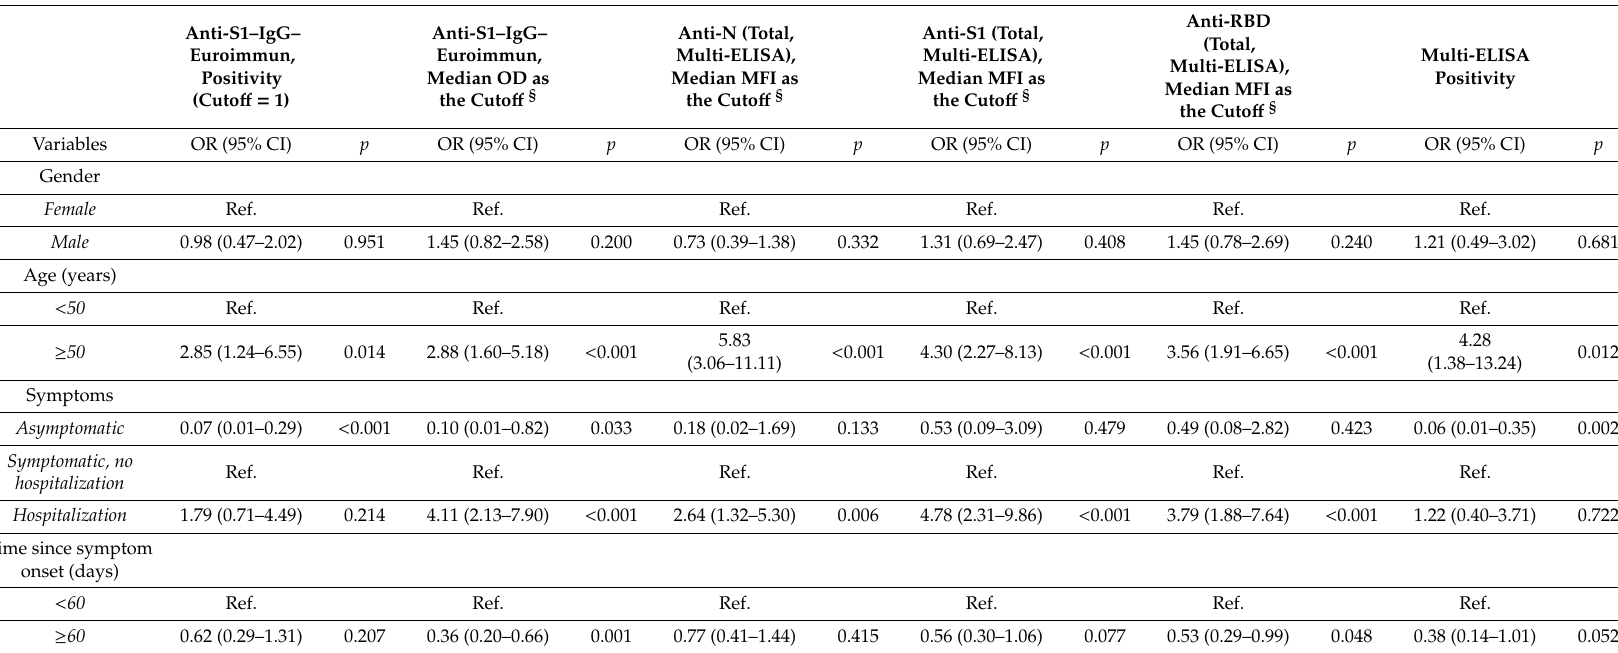
Table 4. Results of the multivariate logistic regression analysis examining associations between anti-SARS-CoV-2 antibody levels and demographic-clinical variables. Bold cells denote statistically significant